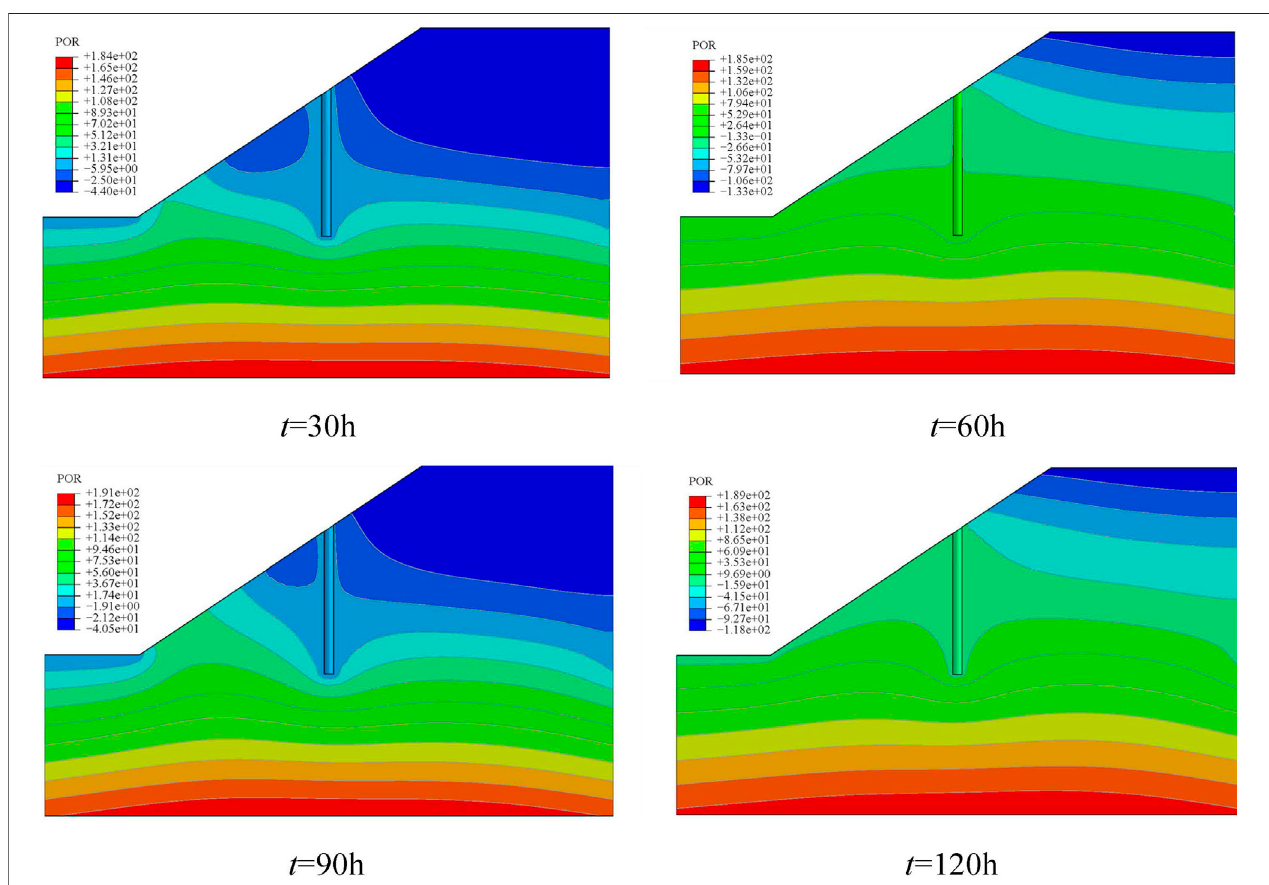
FIGURE 6 | Distribution of pore water pressure of the slope at different times in the form of double peak.